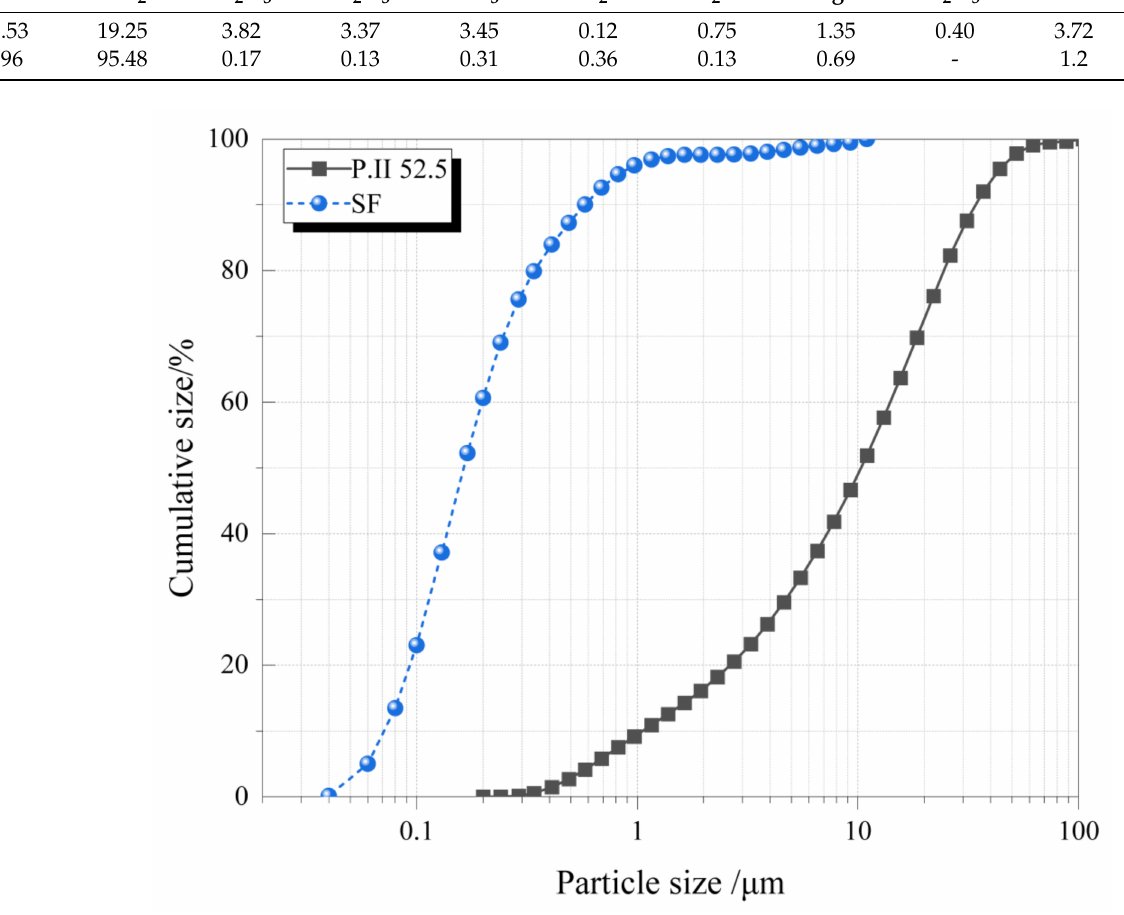
Figure 1. Particle size distribution of used materials.